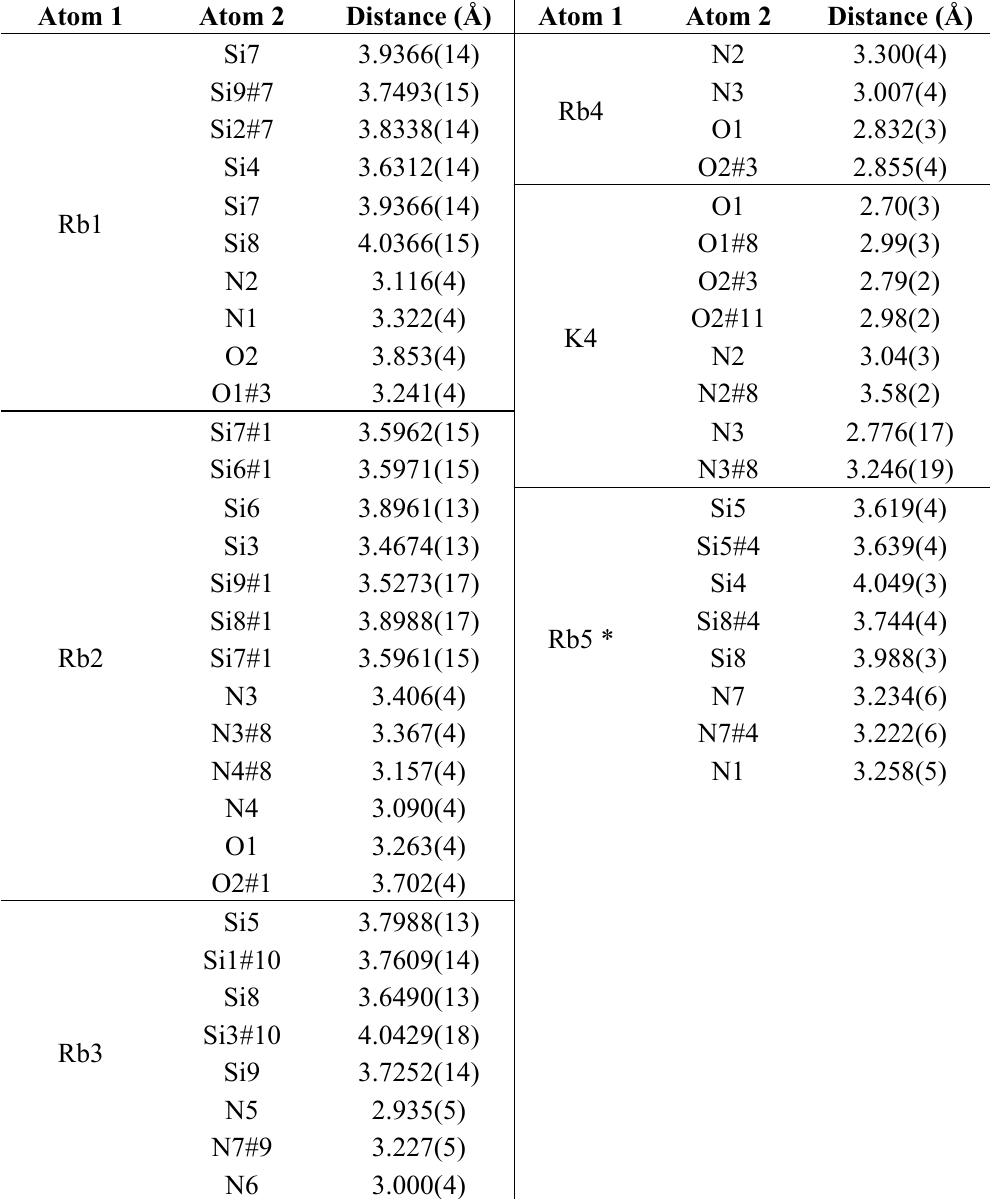
Table 3. Distances for the coordination of the cations according to Figure